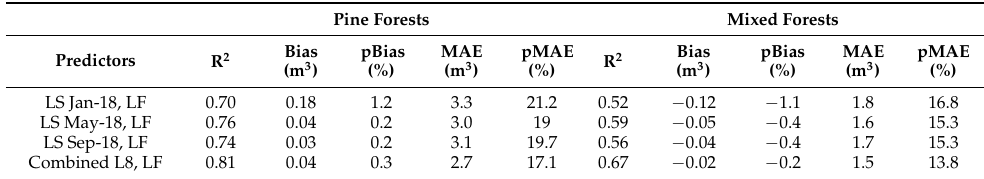
Table 3. Summary of model performance with combined Landsat and LANDIRE predictors. LS indicates Landsat-based predictors at specified date, LF indicates LANDFIRE-based predictors. The hold-out test sample size was 2269 and 2226 for pines and mixed forests,